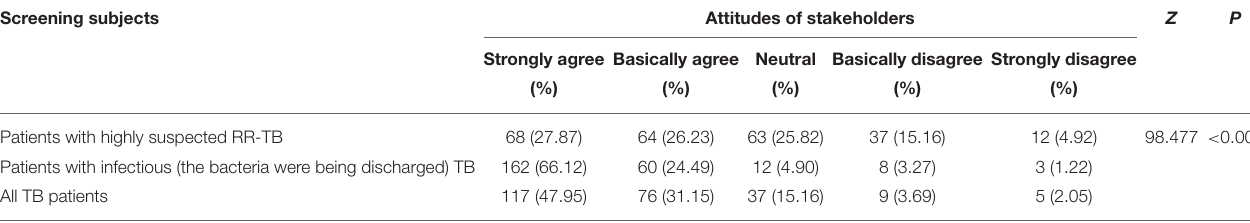
TABLE 4 | Service provider stakeholder attitudes regarding the selection strategies of the subjects for the RR-TB screening. Screening subjects